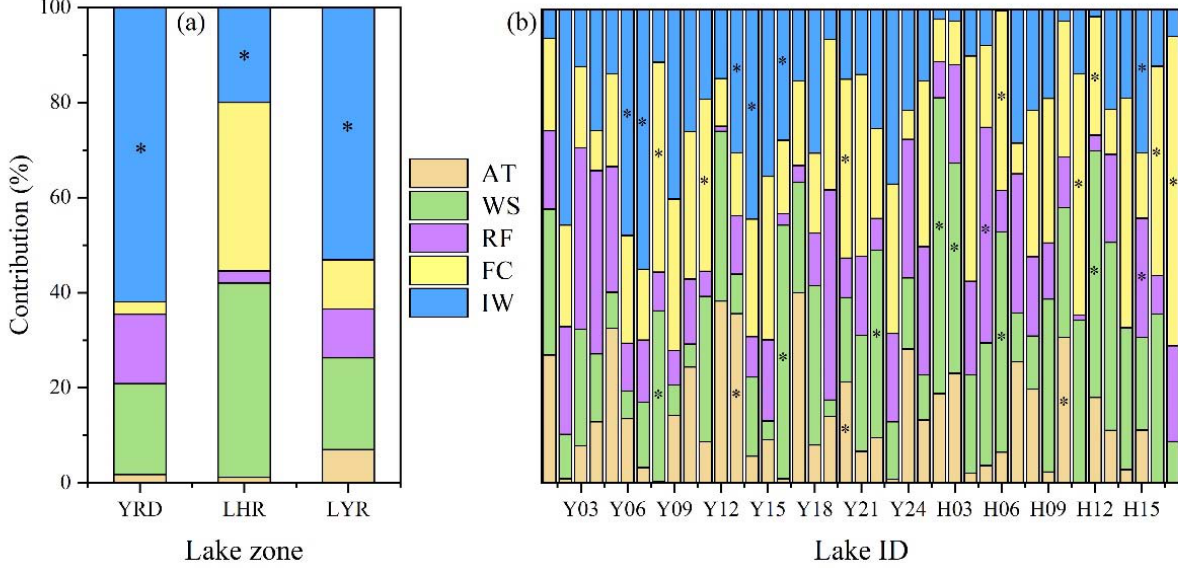
Figure 14. ( a ) The relative contribution percentages of different factors to the interannual changes in the TSI of lakes in the YRD, LHR, and LYR; ( b ) the relative contributions of different factors to the interannual changes in the TSI of all lakes in the YRD. Here, AT, WS, RF, FC, and IW represent air temperature, wind speed, rainfall, fertilizer consumption, and industrial wastewater, respectively, and the symbol “*” represents p < 0.05.